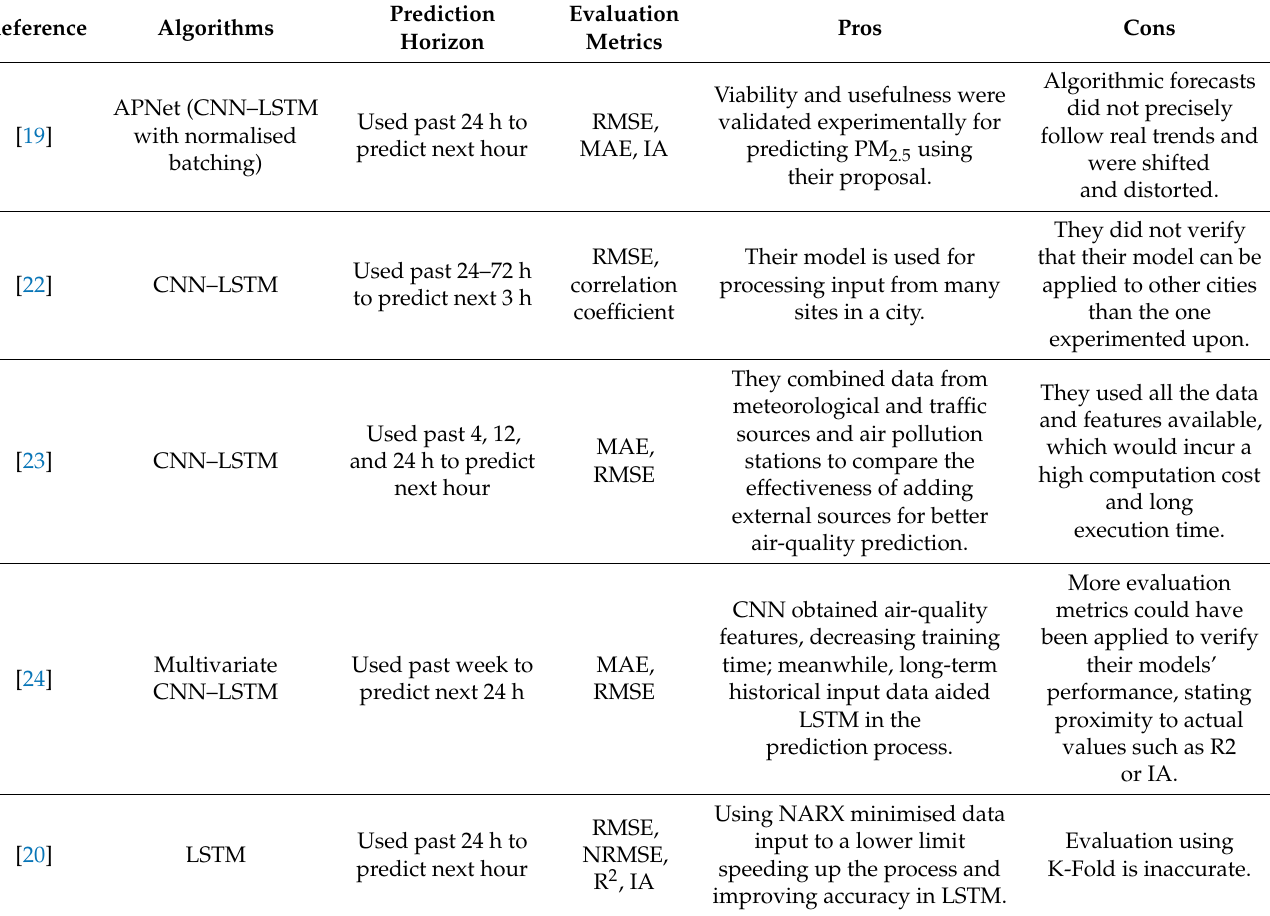
Table 1. Related work